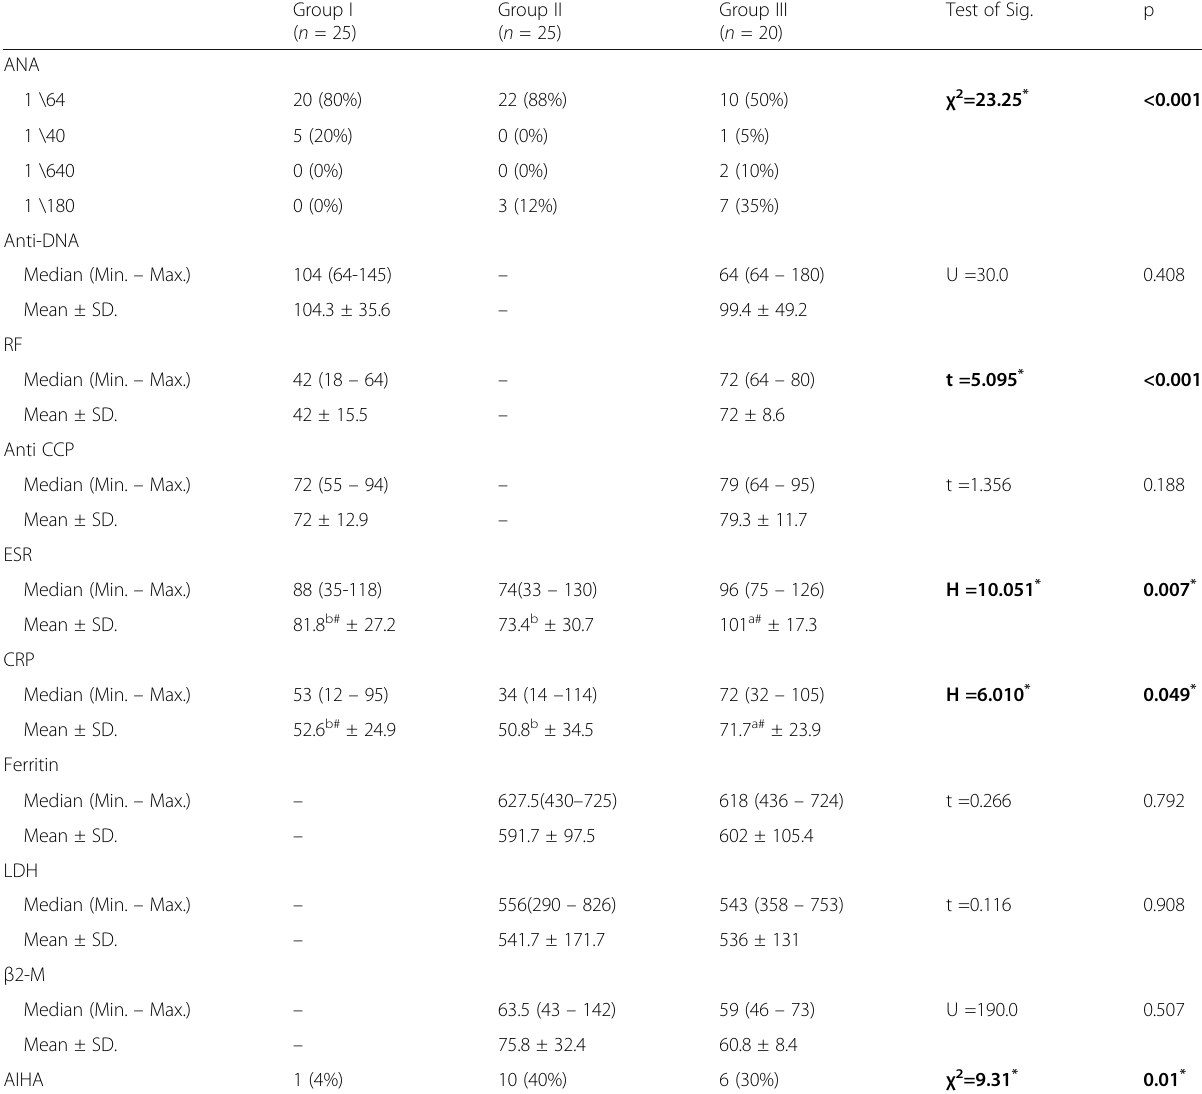
Table 2 Laboratory data of the three studied groups